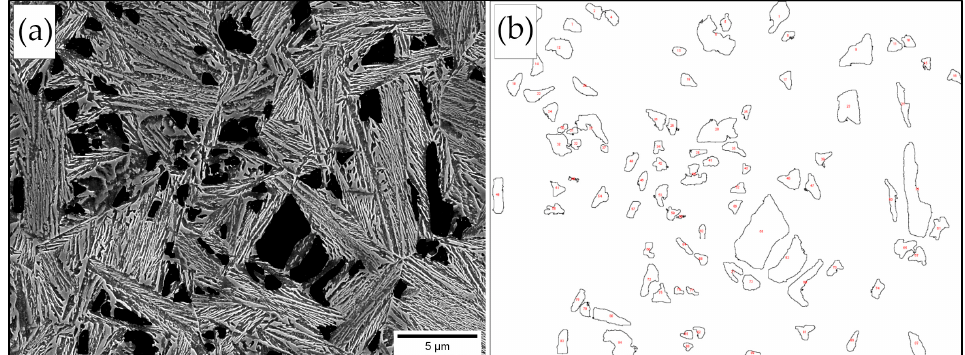
Figure 11. Example of quantitative analysis of retained blocky austenite dimensions. ( a ) Micrograph highlighting the retained blocky austenite; ( b ) outlines of retained blocky austenite subjected to measurements using ImageJ software. Sample after isothermal treatment at 275 °C.